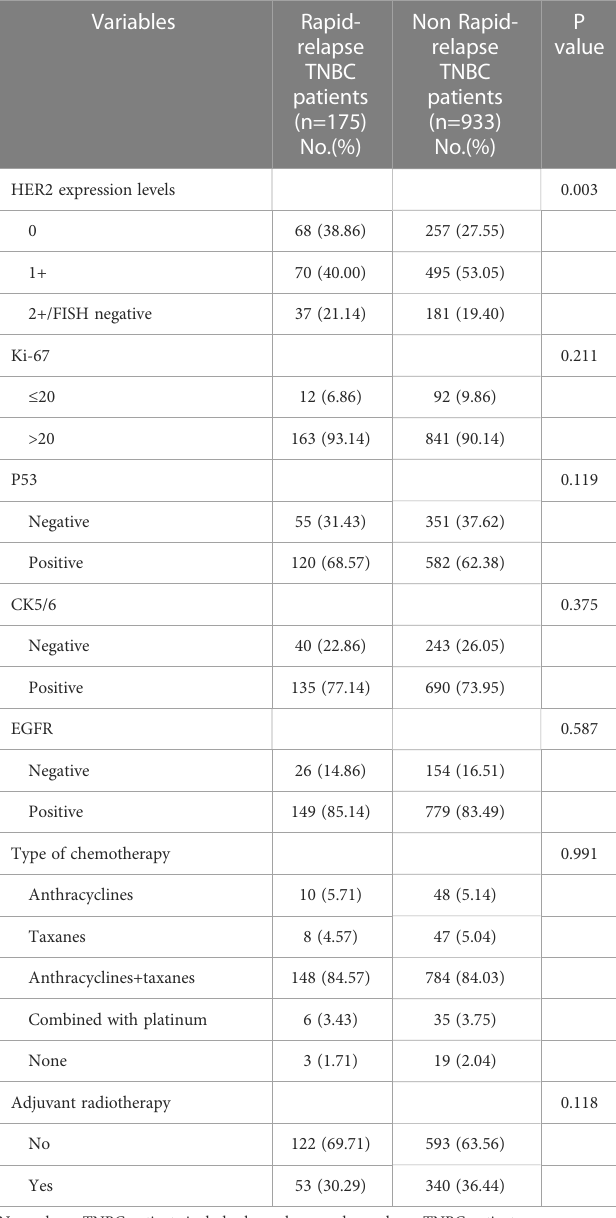
(Figure 5). The median disease-free survival and median overall survival of different recurred TNBC patients are presented in Table 5. The overall survival analysis of all TNBC patients in six predictors for rapid relapse are presented in Figure 6. Different expressions of sTILs(Low, intermediate, and high) and different expression levels of Her2 (IHC 0, IHC 1+, or IHC 2+/FISH- negative) were detected in tumors by using hematoxylin and eosin staining (H&E×200, Figure